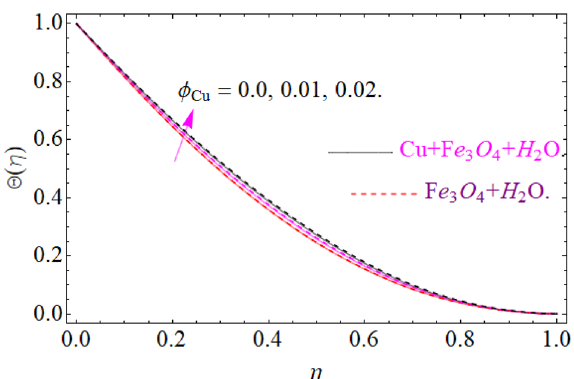
Figure 14. Impression of φ Cu on Θ( η ), When M = 0.2, φ Fe 3 O 4 = 0.02, Pr = 6.2, Re ω = 0.3, Re � = 0.13 .